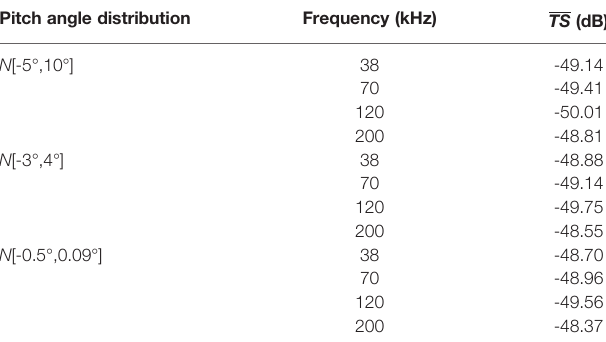
TABLE 2 | TS values for different pitch angle distributions at four